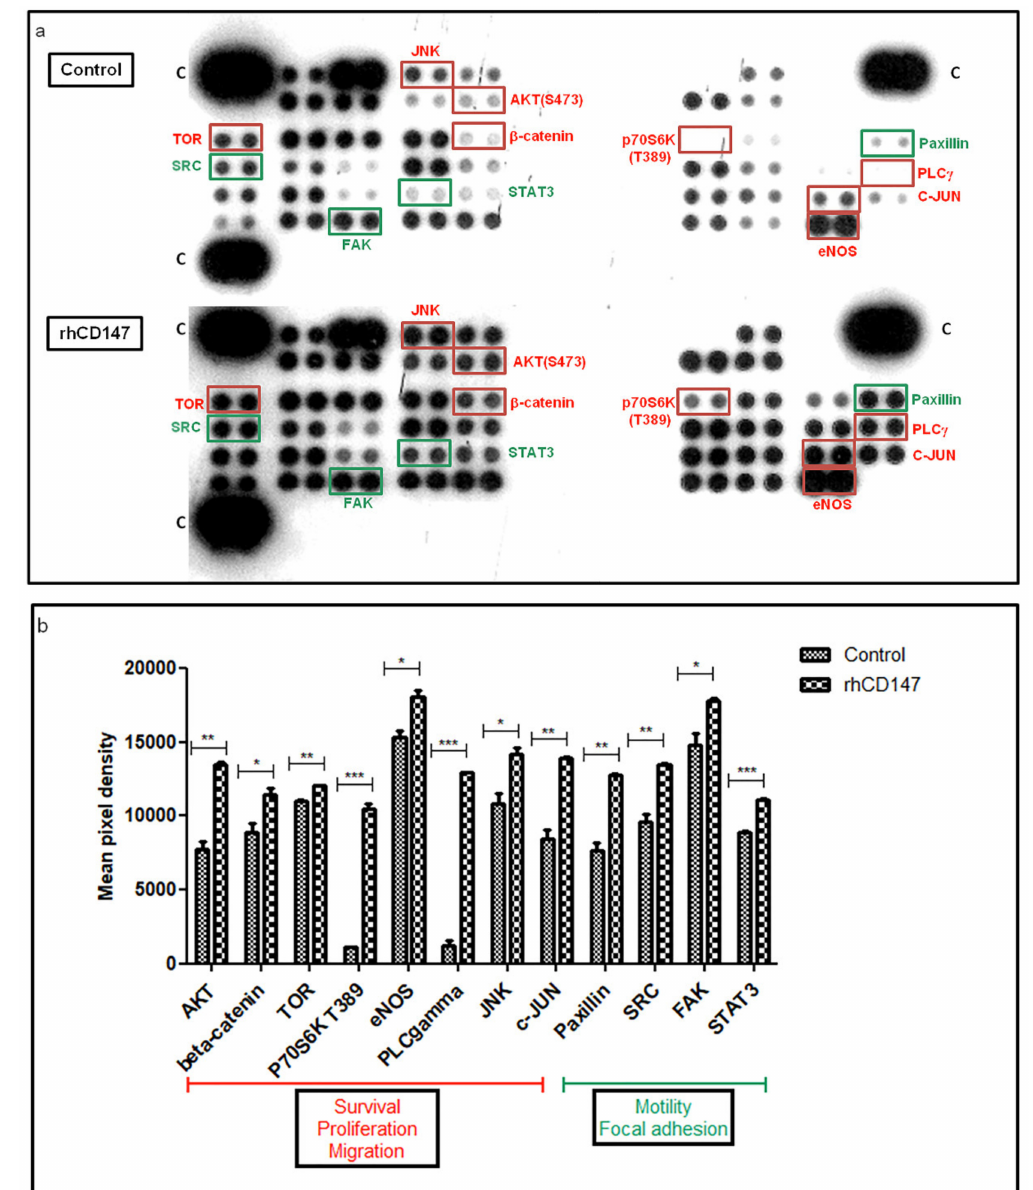
Figure 5. Signaling pathways involved in CD147 lymphangiogenesis regulation. ( a ) Whole lysates from LECs treated or not with rhCD147 were collected for human phosphokinase array analysis. Each membrane contains 46 specific kinases and a positive control (C). Antibodies were spotted in duplicate. ( b ) Mean pixel density of spots was quantified. Each bar represents the mean of duplicate spots. Bars represent SD; * p < 0.05, ** p < 0.005, *** p <